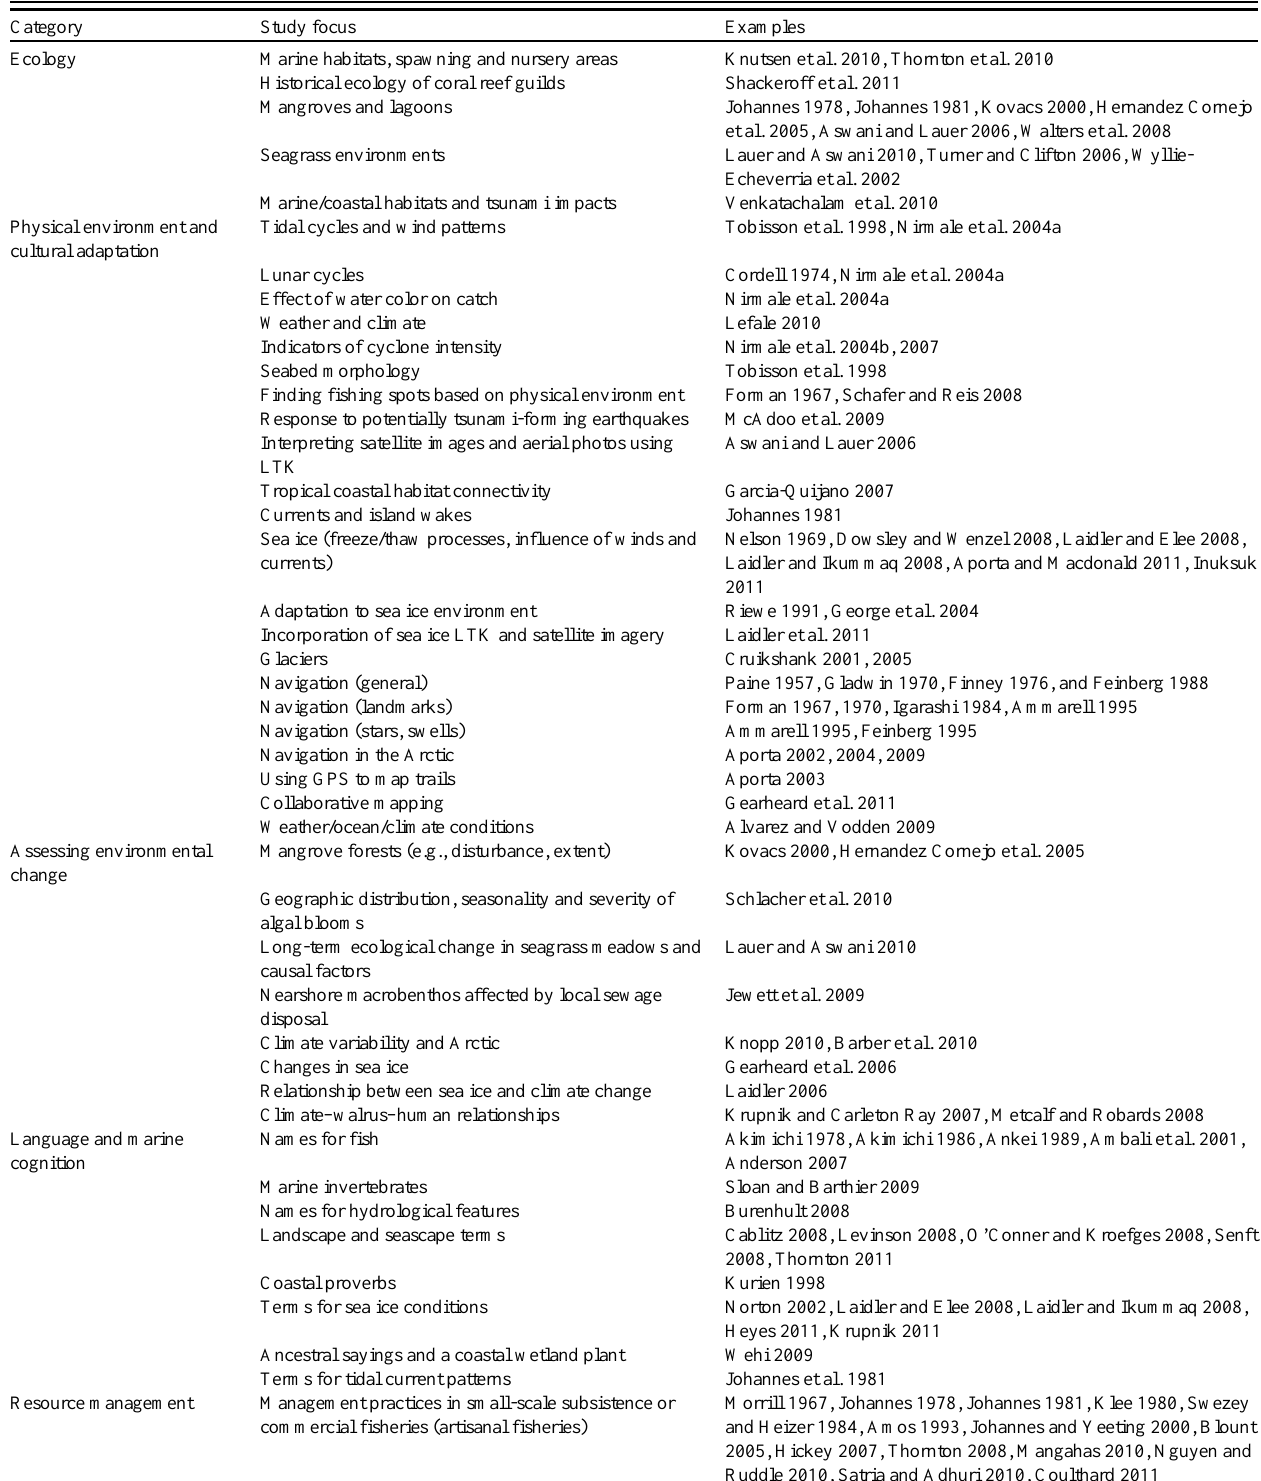
Table 3 . How the substantive focus of marine LTK studies has broadened: examples from the literature.